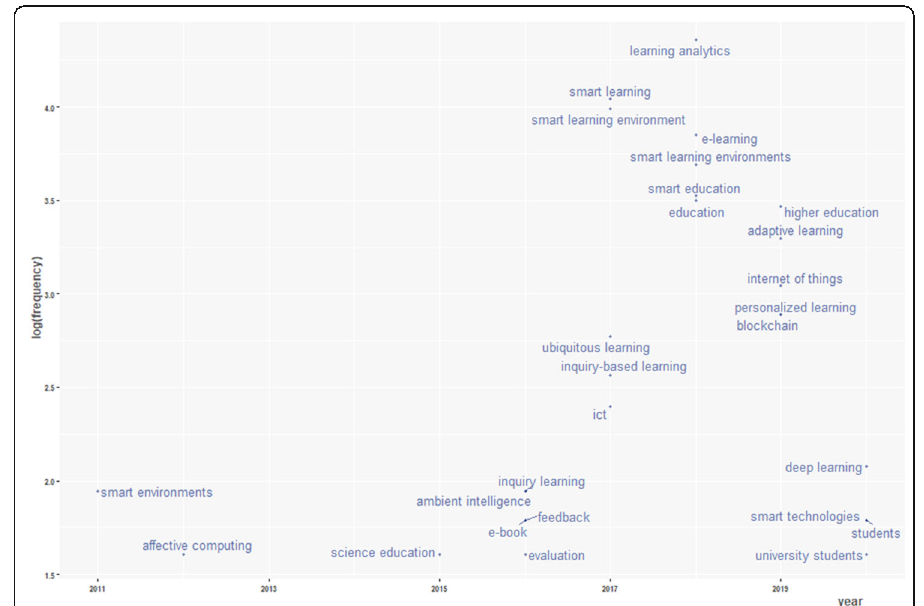
Fig. 11 Trending topics between 2011 to